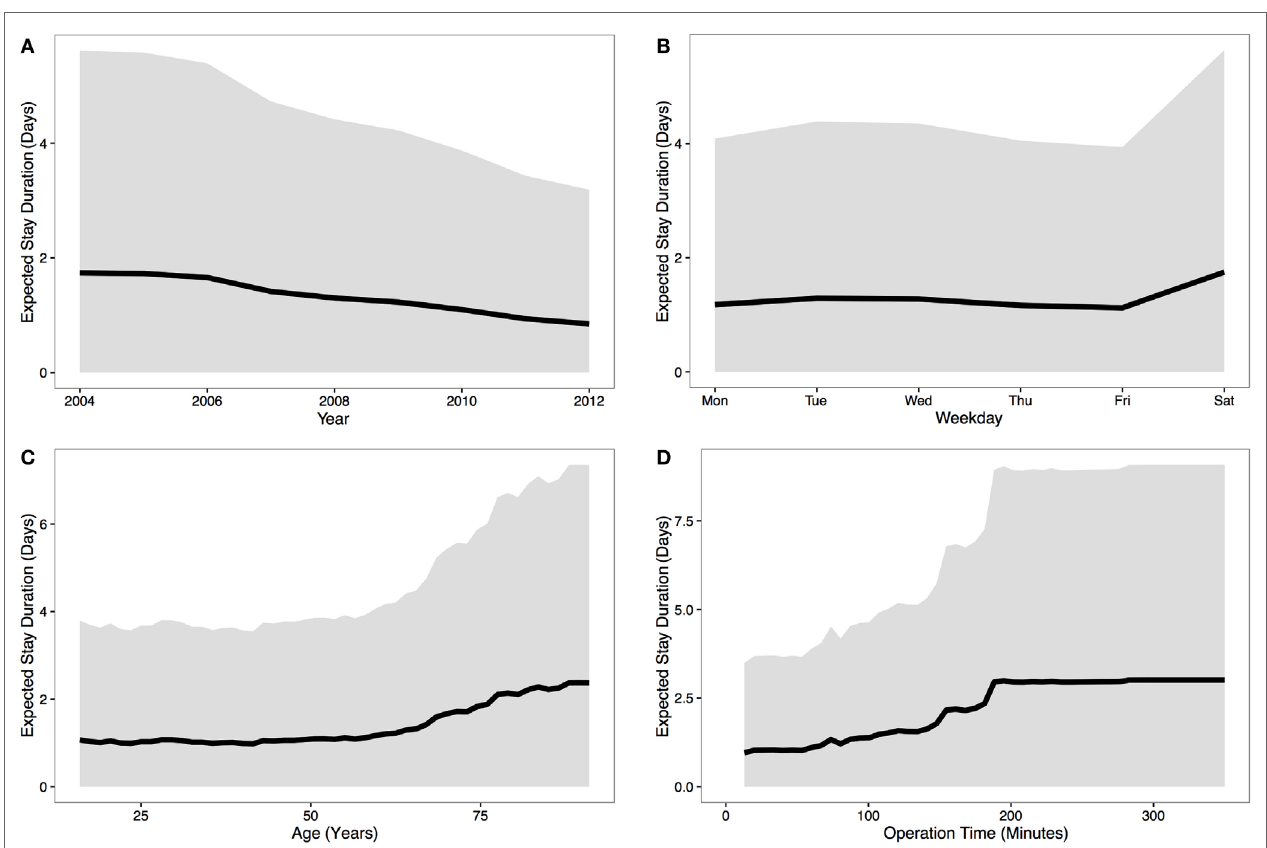
FiGure 1 | Predicting patient stay duration . The results from the model are presented using line plots (the median prediction is represented by a solid black line and the gray region represents the 95% quantile). (A) These data show a steady downwards trend in stay duration over the nine relevant years; (B) the duration of stay is longer for operations on Saturdays – most likely due to weekday discharge; (c) for patients above 55 years of age, stay duration rapidly increases with age; and finally, (D) stay duration also increases with operation time – presumably an indicator of complications in surgery or intrinsically more difficult cases. Interestingly, stay duration reaches a plateau for operations over ~3 h, though there are relatively few data points for surgeries of this length – and as such, this relationship should be treated with